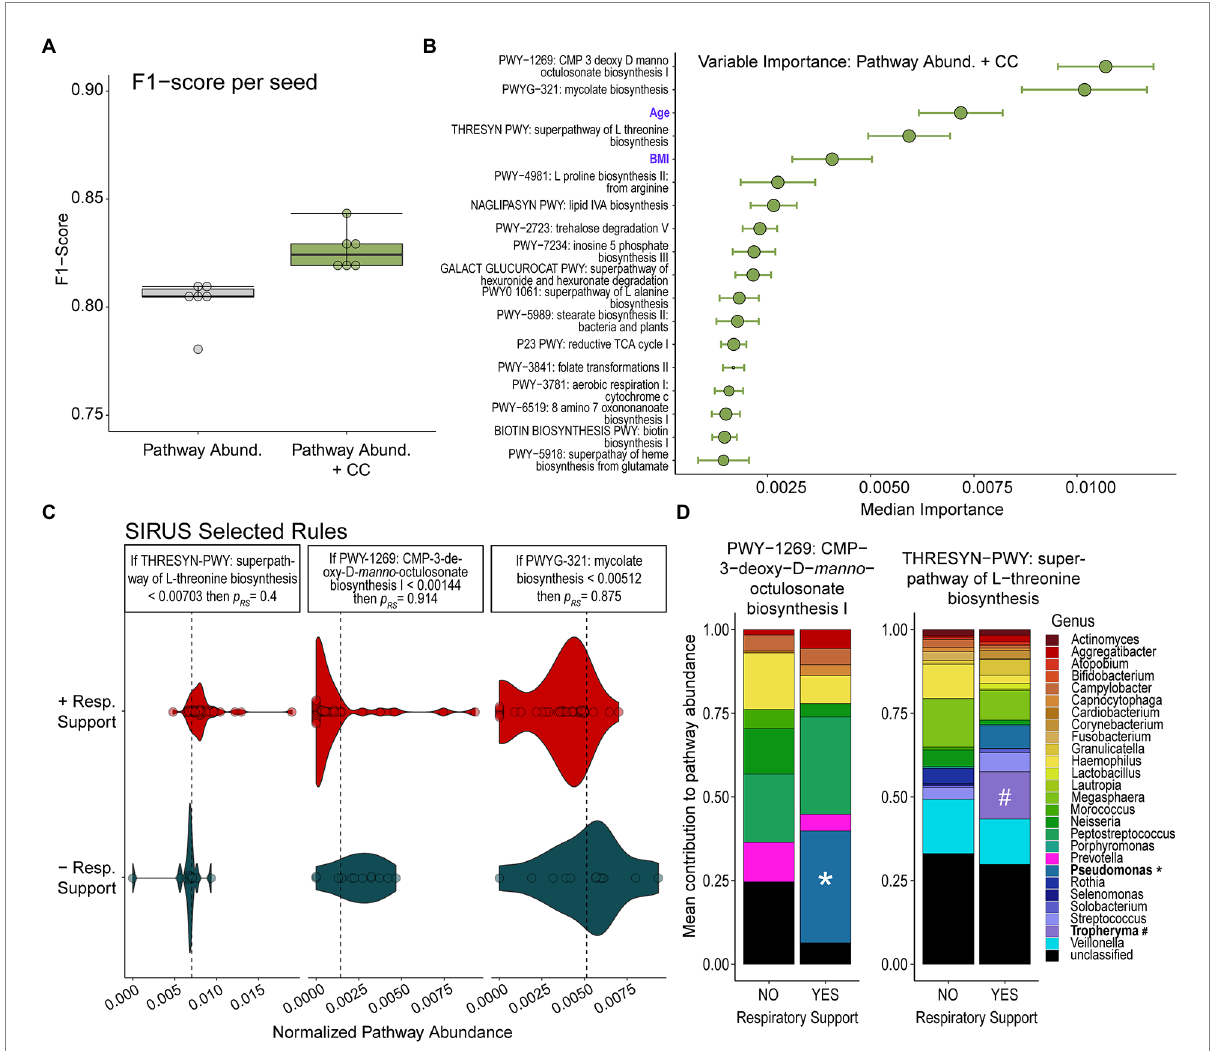
FIGURE 3 Random Forest Classification Using Metabolic Pathways. (A) F1-scores of RFC models built on relative abundance of detected metabolic pathways alone or in combination with clinical covariates (CC) show that models combining both data modalities perform slightly better. (B) Median relative importance of variables in predicating the need for respiratory support from the model trained on relative pathway abundances and clinical covariates (median importance ± median absolute deviation) are shown. The size of the circle represents how often each feature was selected. Features which do not contribute to the predictive model are not shown. (C) The relative abundance of top metabolic pathways or values of clinical features determined to be important in predicting need for respiratory support by our RFC model are displayed along with discriminative rules based on the probability of requiring respiratory support (p res ). (D) Contributions of detected bacterial genera to pathway abundance of CMP- 3-deoxy-D-manno-octusonate biosynthesis and L-threonine biosynthesis in patients who did or did not go on to require respiratory support are shown. The detection of Pseudomonas contributing to the abundance of the CMP-3-deoxy-D-manno-octusonate pathway and the detection of Tropheryma contributing to the abundance of the L-threonine biosynthetic pathway are notable and